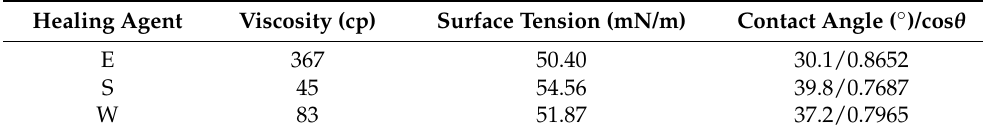
Table 2. Surface tension and contact angle of the three kinds of healing agents. Healing Agent